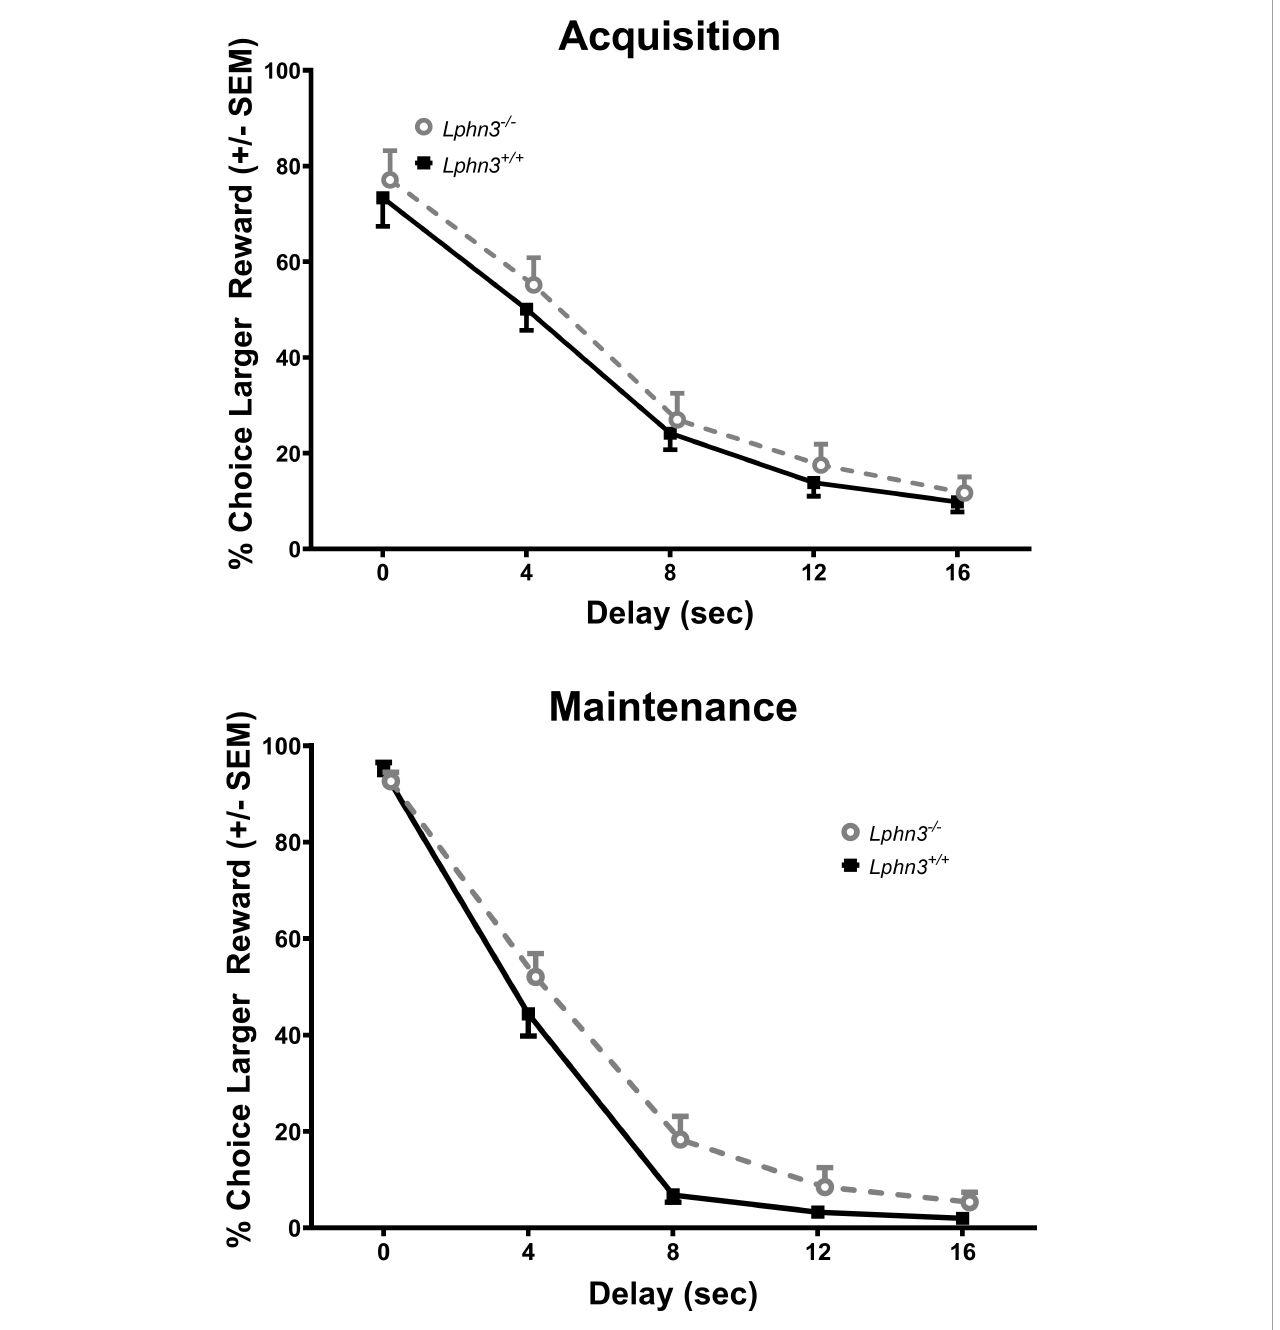
FIGURE5 Percent choice for the larger reward during acquisition (top) and maintenance responding (bottom) for the Lphn3 − / − (knockout) and Lphn3 + / + (wildtype) rats with unequal trial lengths. Genotype had no effect of on delay-discounting (DD) performance.